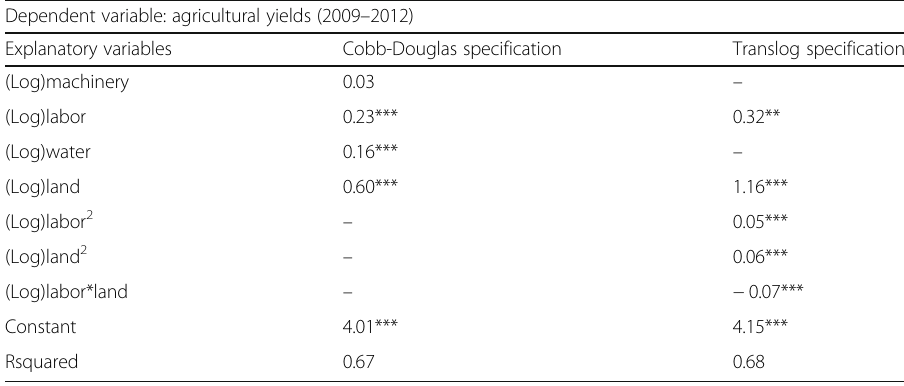
Table 3 Empirical estimates of selected production functions empirical